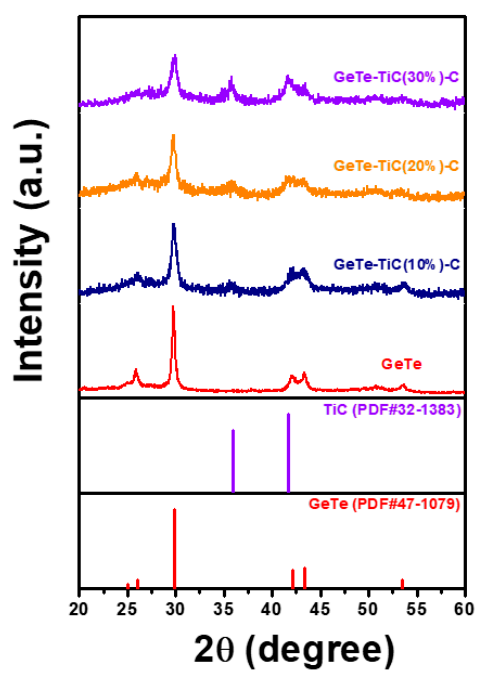
Figure 2. X-ray diffraction (XRD) patterns of GeTe and GeTe-TiC-C composites.